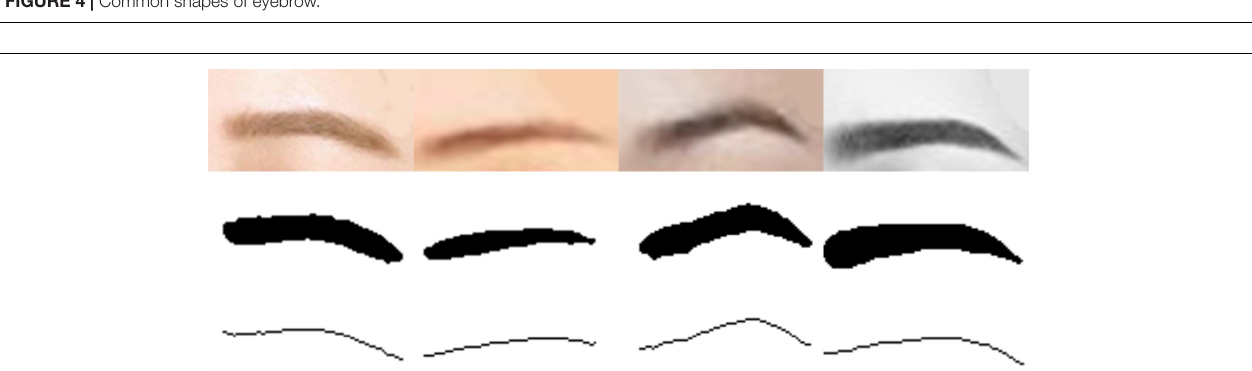
FIGURE 4 | Common shapes of